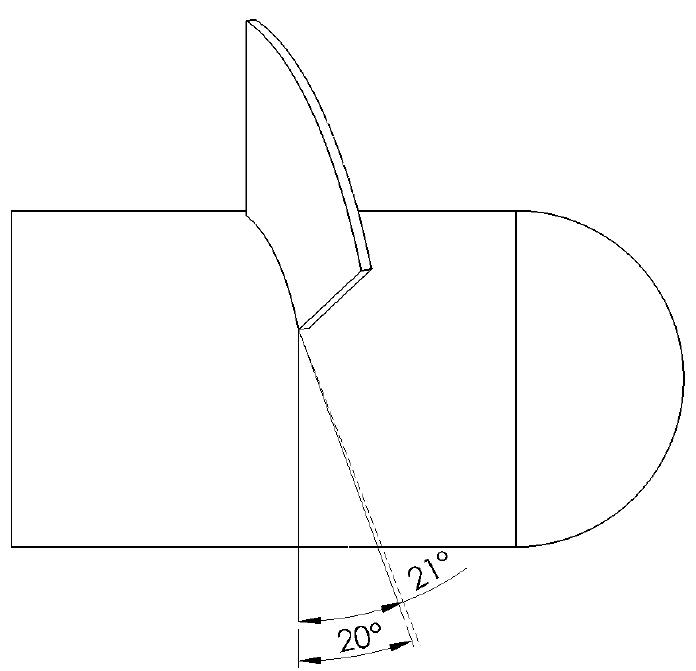
Figure 11. Geometry of the model with marked angles θ = 20 ◦ and θ = 21 ◦